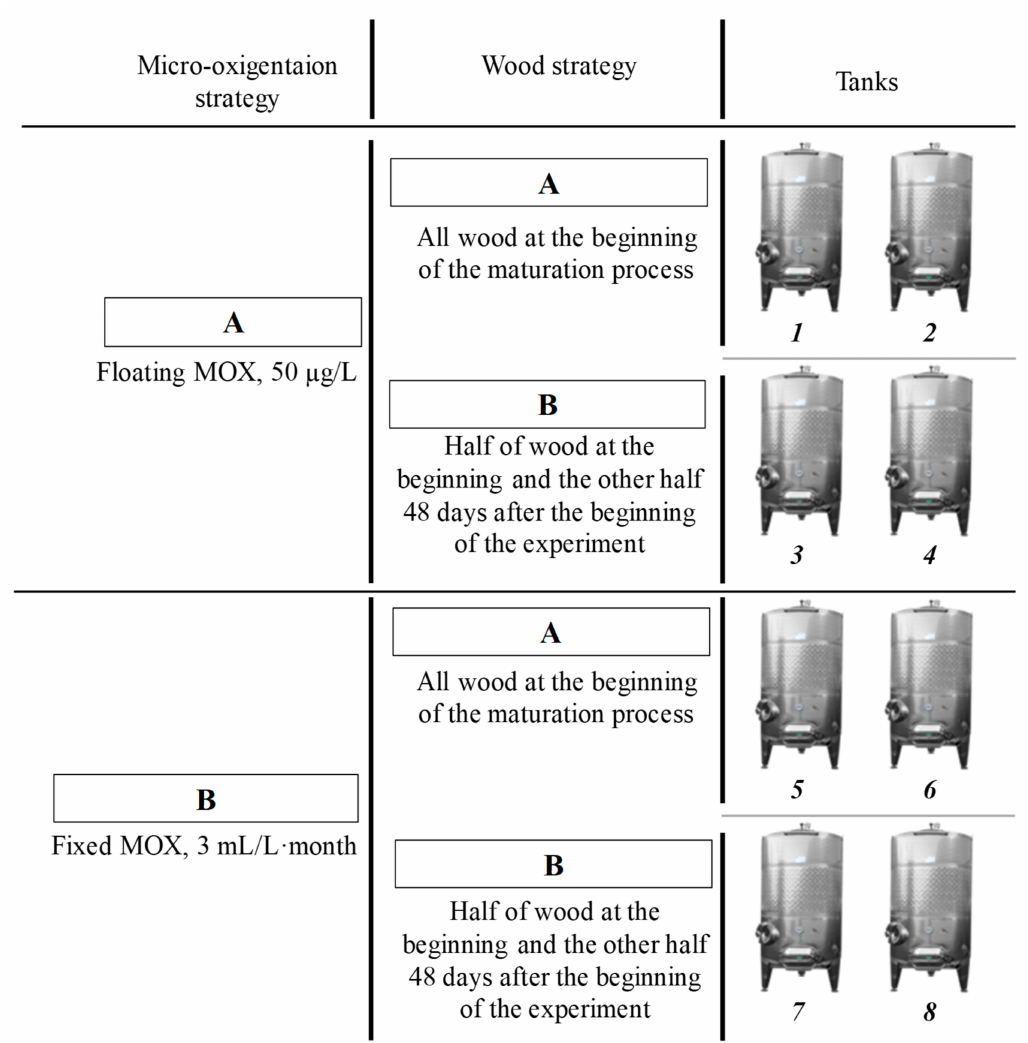
Figure 1. Wine micro-oxygenation (MOX) and wood strategies